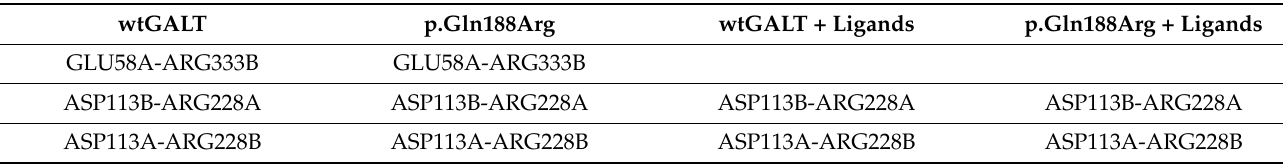
Table 4. Couples of residues involved in stable intersubunit salt bridges in simulations at 334 K. Couples of residues are considered to have a stable salt bridge interaction when the sum of % of existence of the salt bridges between the two residues is